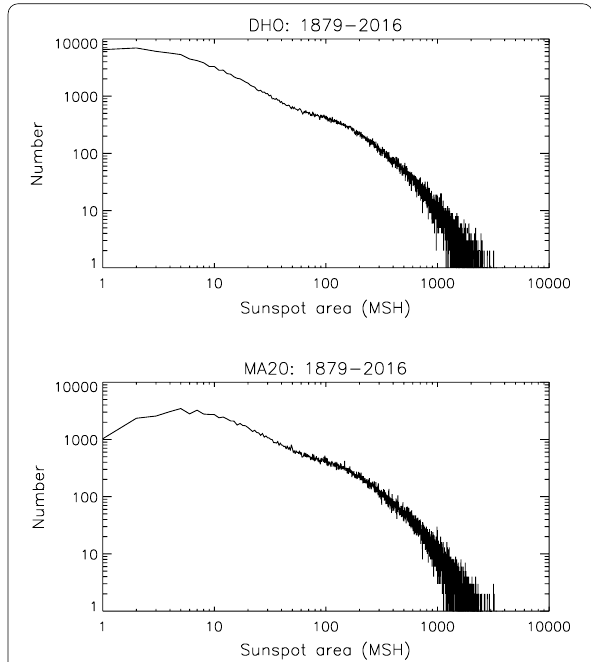
Fig. 4 Histogram of occurrence number as a function of sunspot area in the DHO (upper panel) and MA20 (lower panel) catalogues